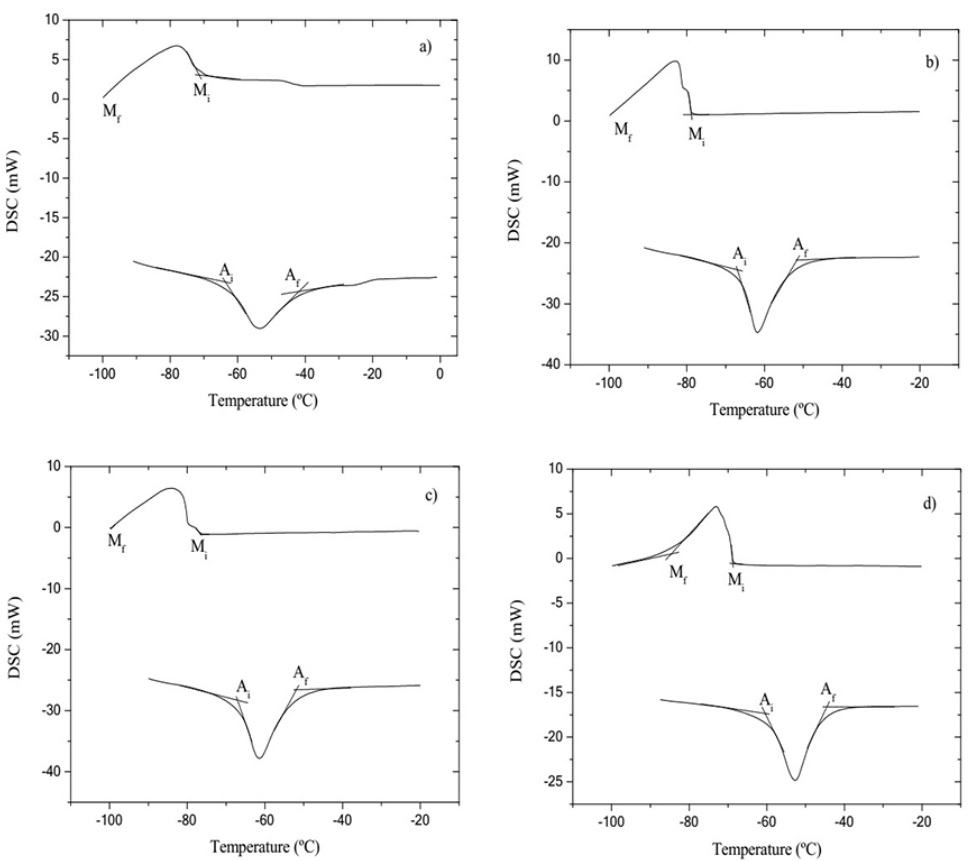
Figure 2. DSC - phase transformation temperatures as a function of the solidification direction: (a) 0º SD, (b) 30º SD, (c) 60º SD, (d) 90º